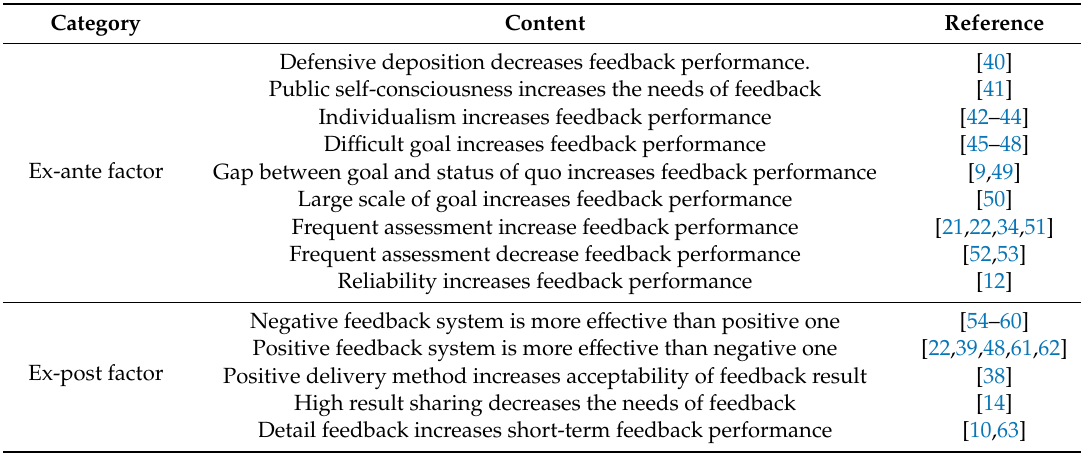
Table 1. Two category of factors determining the e ff ect of